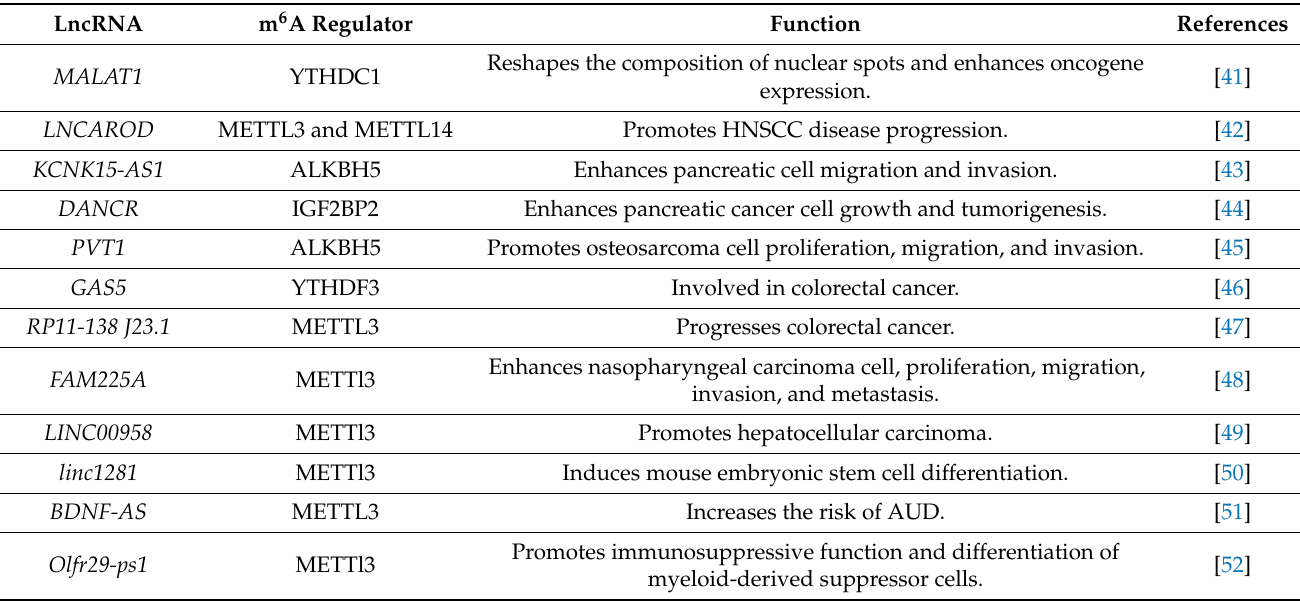
Table 1. A non-exhaustive list of m 6 A modified